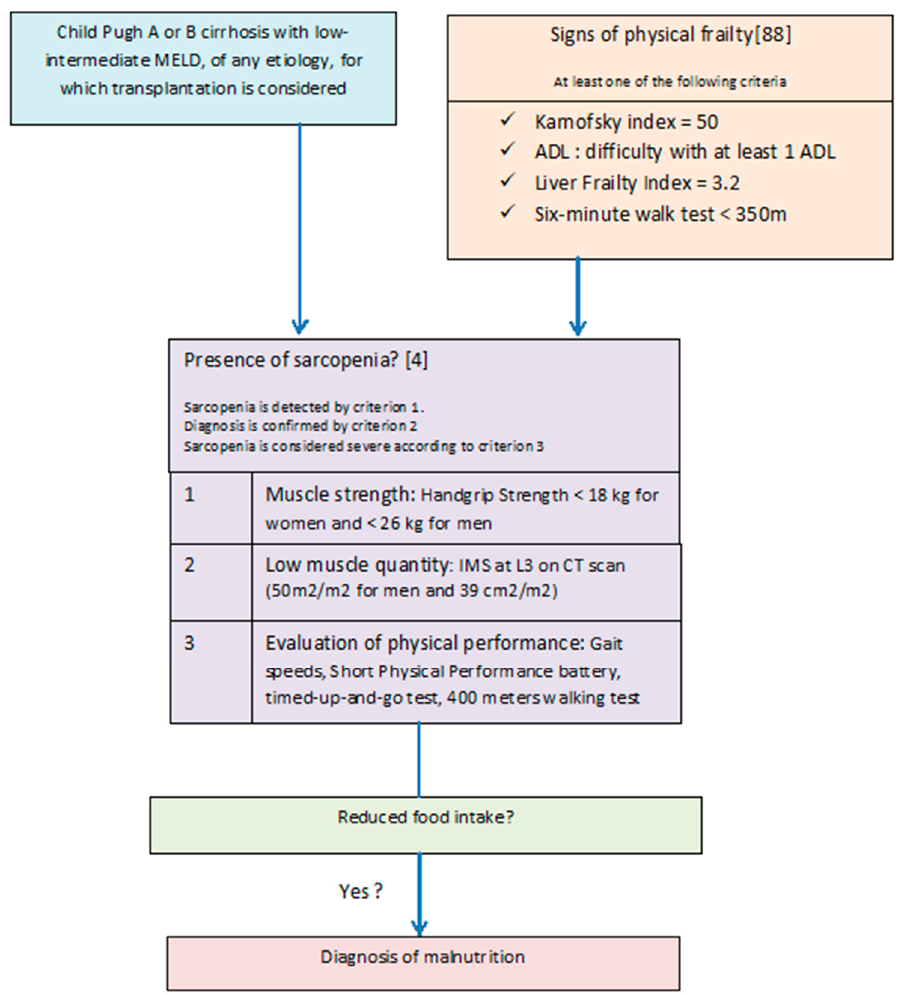
Figure 1. Proposed algorithm for the assessment of malnutrition in cirrhosis.